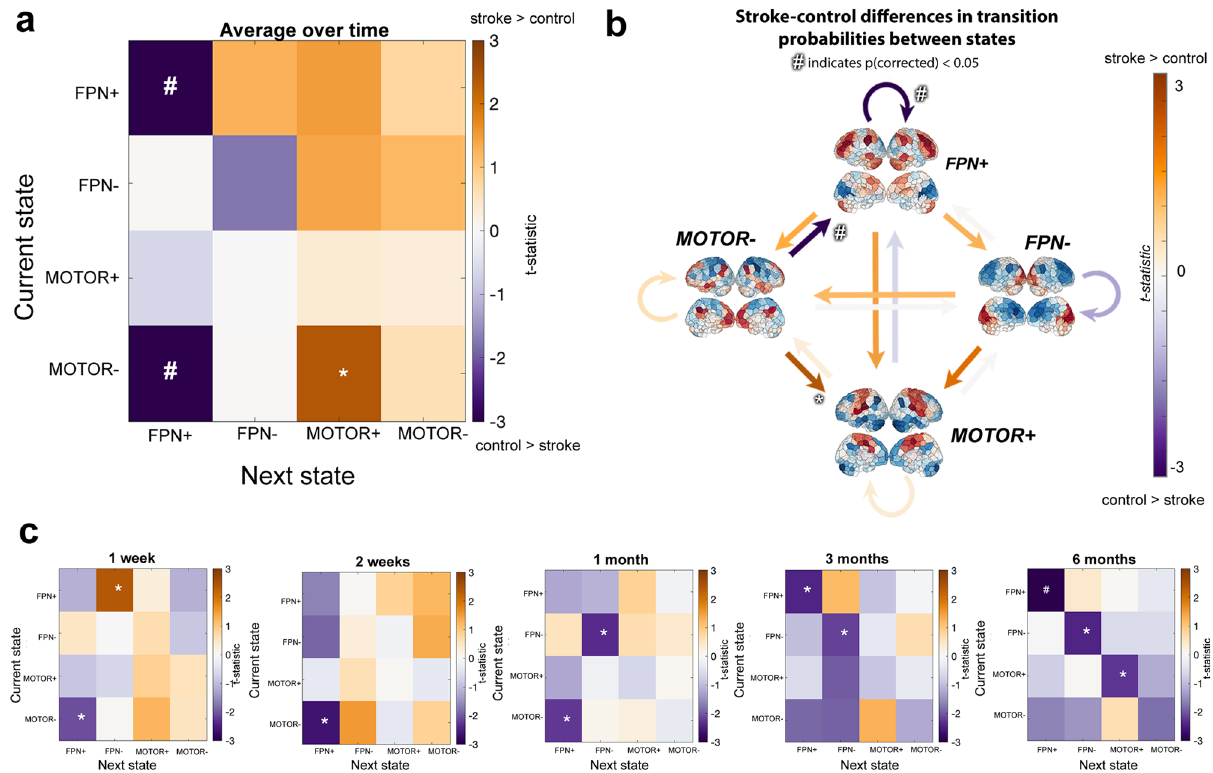
Fig. 4 Differences in transition probabilities between stroke and control groups. Transition probabilities include persistence probabilities, i.e. the probability that a state does not transition out of itself. a Differences in average transition and persistence probabilities (over time) between groups. b Same data as a , visualized with arrows colored by t-statistic. c Differences in transition probabilities at each follow-up session. T-statistics (stroke- control) are displayed on the color map; hashtags ( # ) represent p values < 0.05 after multiple comparisons correction, single asterisks (*) represent signi fi cant uncorrected p values < 0.05. n = 24 biologically independent control subjects at each time point; n = 23, 23, 22, 21, 20 biologically independent stroke subjects for time point 1, 2, 3, 4, and 5, respectively.